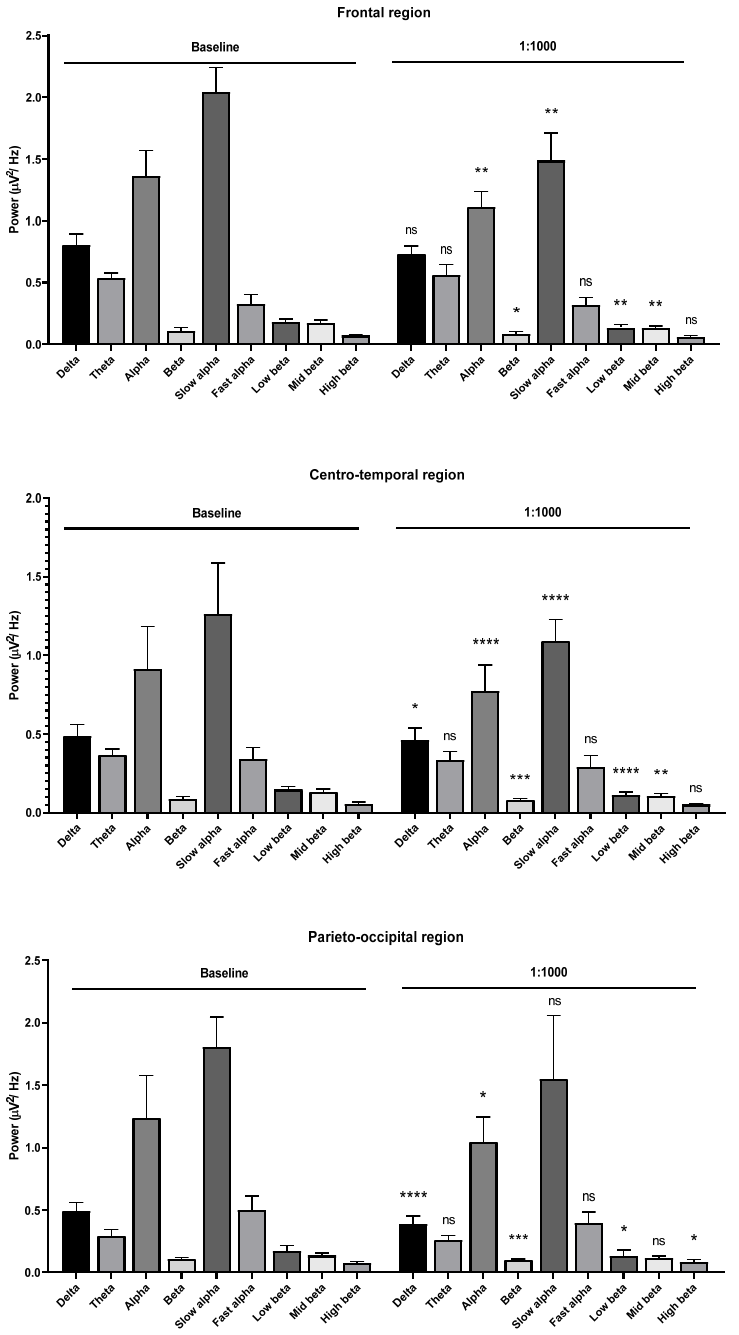
Figure 2. Effects of Litsea cubeba oil inhalation at a 1:1000 dilution on the delta, theta, alpha, beta, slow alpha, fast alpha, low beta, mid beta, and high beta wave powers: ( upper ) frontal region; ( middle ) centro-temporal region; ( lower ) parieto-occipital region. p value: not significant (ns) ≥ 0.05, * < 0.05, ** < 0.01, *** < 0.001, and **** < 0.0001.